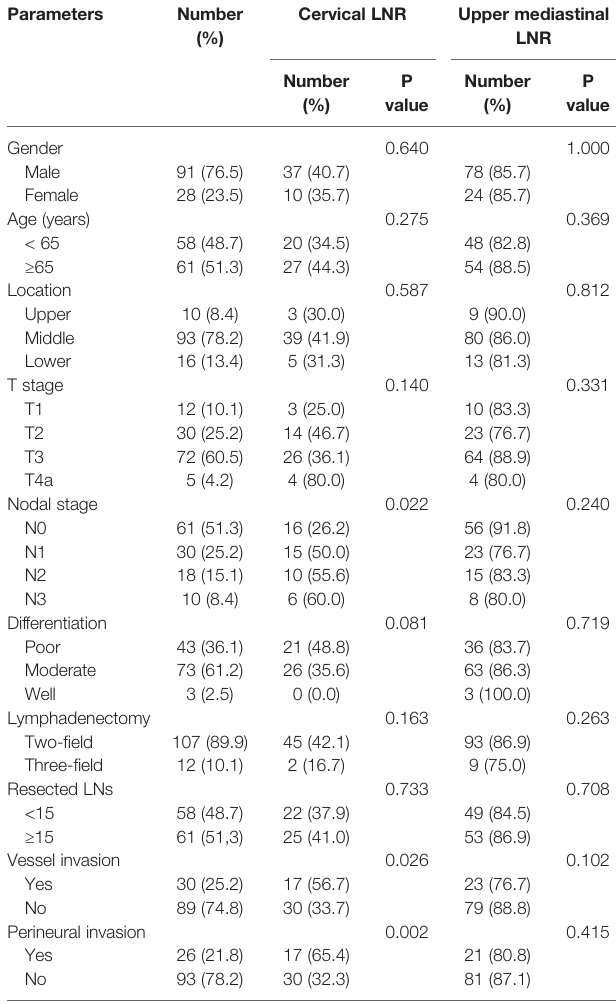
TABLE 1 | Clinicopathological characteristics of